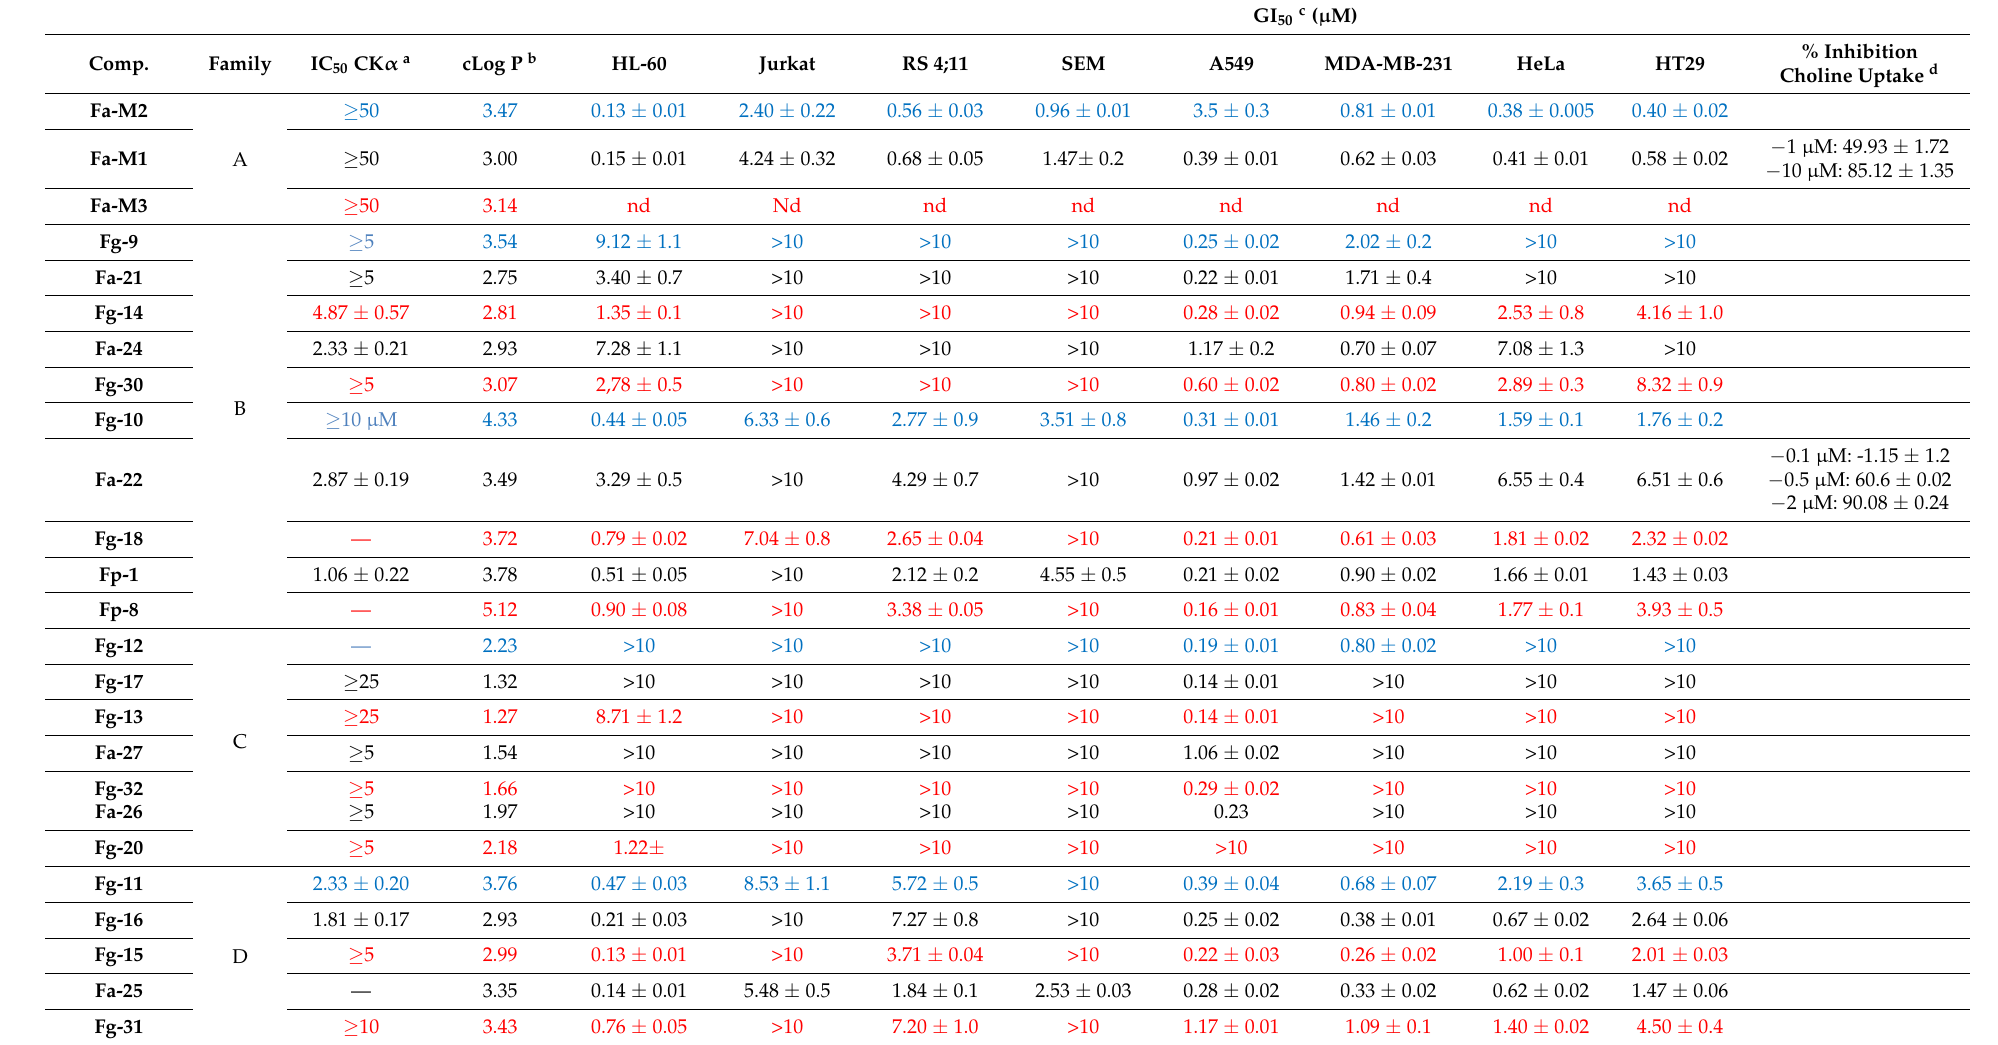
Table 4. In vitro inhibitory effects of final